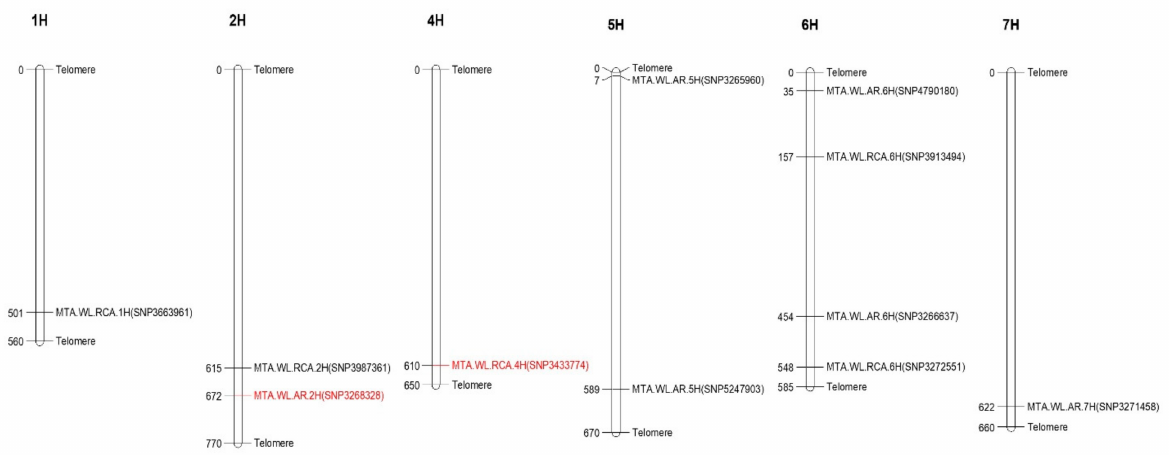
Figure 4. Genetic linkage map of identified MTA. MTA.WL.AR stands for the association between markers and AR development under waterlogging condition; MTA.WL.RCA stands for the associa- tion between markers and RCA formation under waterlogging condition. Red-color MTA are the lead MTA. Physical position of the chromosome was used to detect the respective